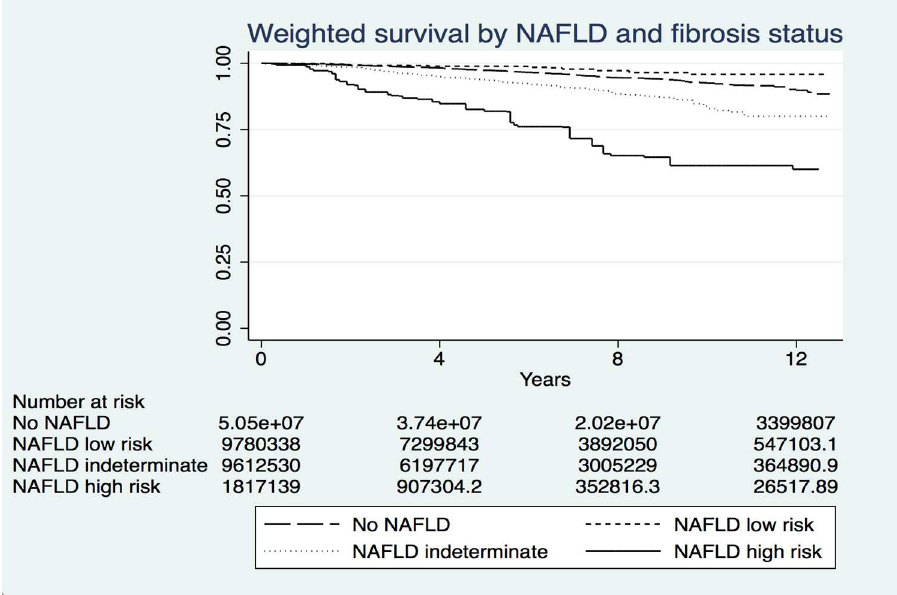
Fig 1. Weighted survival by NAFLD and fibrosis status based on NFS cutoffs in the National Health and Nutrition Examination Survey, 1999–2010. NFS cutoffs for advancedfibrosis: low risk < -1.455, indeterminate risk -1.455–0.676, high risk > 0.676.NoNAFLD vs. NAFLD low risk: p = 0.015| No NAFLD vs. NAFLD indeterminaterisk: p < 0.001.No NAFLD vs. NAFLD high risk: p < 0.001|NAFLD low risk of advanced fibrosis vs NAFLD high risk of advancedfibrosis: p < 0.001|